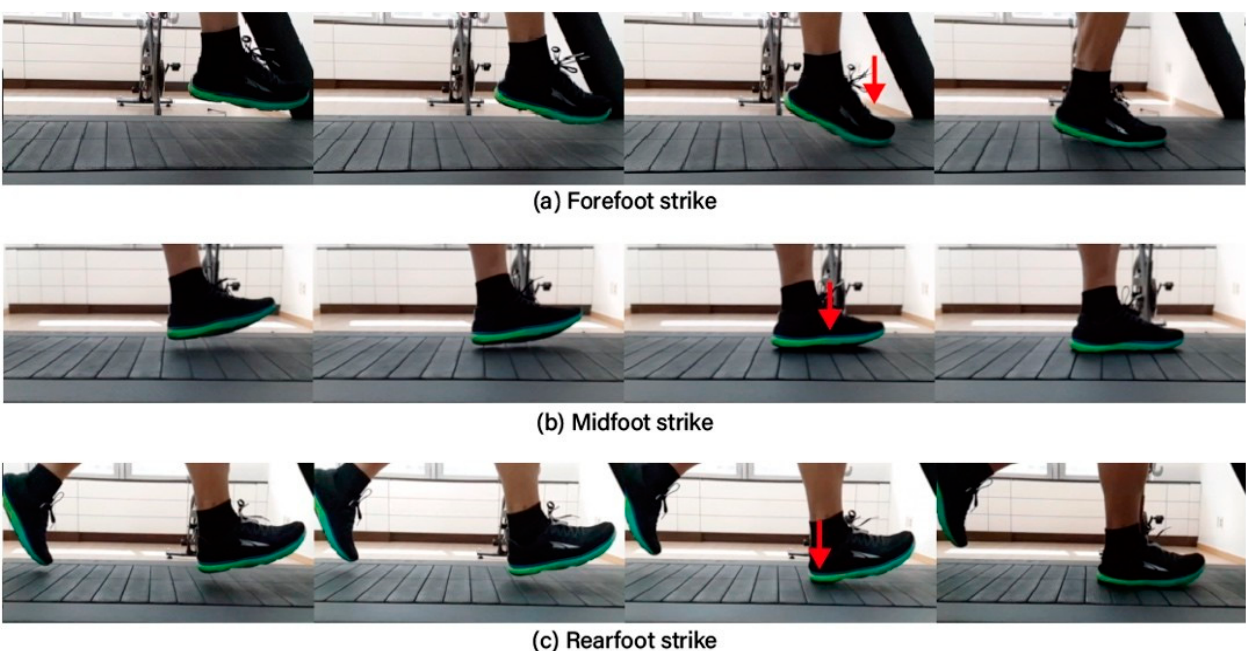
Figure 1. Three different striking patterns; ( a ) forefoot (FF) strike, ( b ) midfoot (MF) strike, ( c ) rearfoot (RF) strike. Red arrow marks the moments in which first contact is made on the ground.